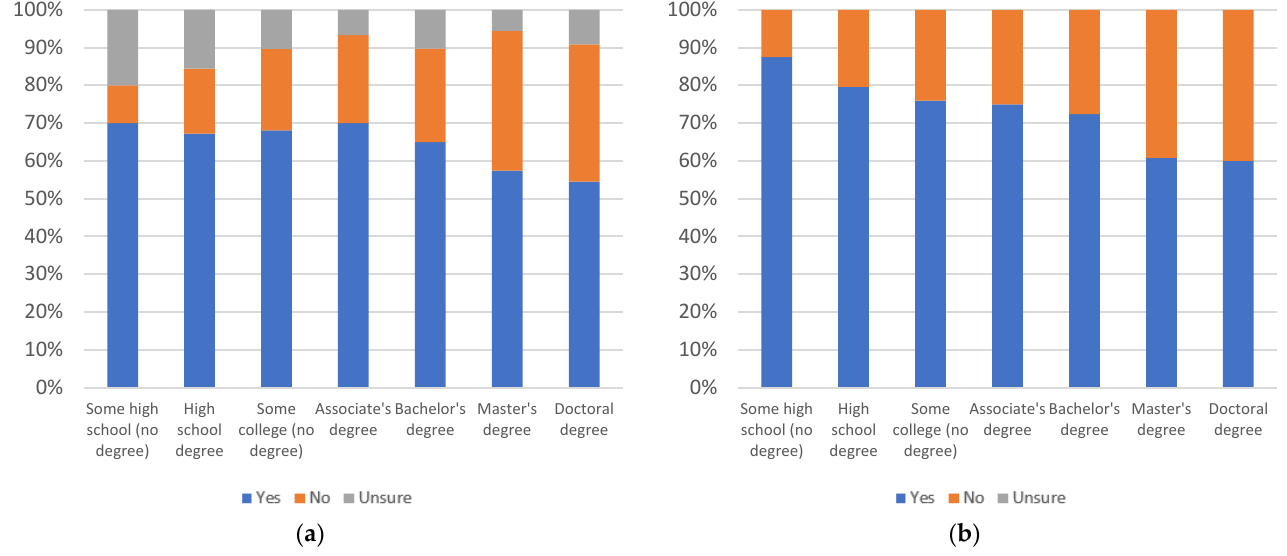
Figure 70. Label helpfulness, by education level: ( a ) with uncertain respondents (left) and ( b ) without uncertain respondents (right).